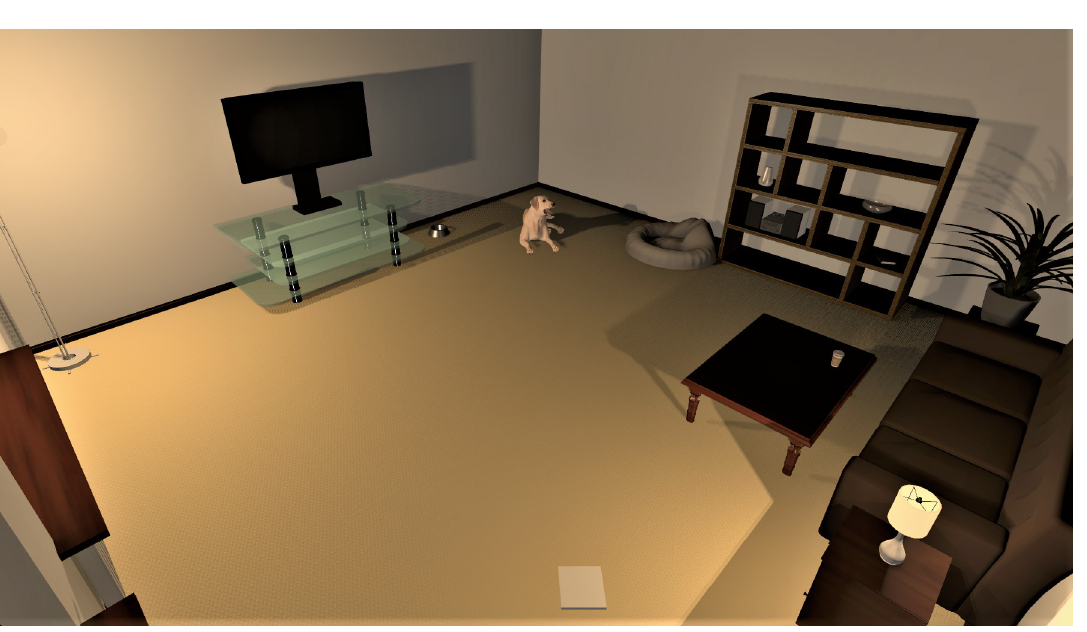
Fig 2. The virtual indoor living room